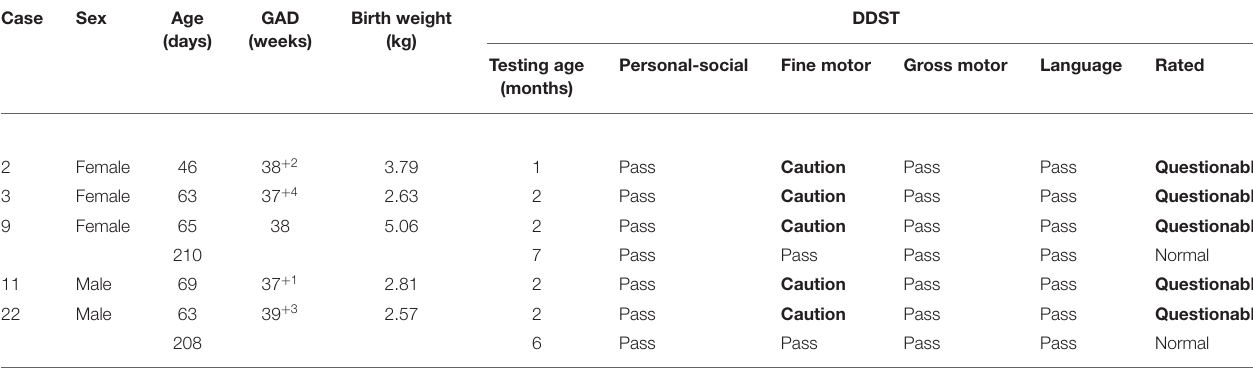
DDST, Denver Developmental Screening Test; GAD, Gestational age at delivery. The bold fonts indicate the information of abnormal infants. “Pass” indicates the child is able to do the task. “Caution” indicates the child is not able to do the task that 75% of